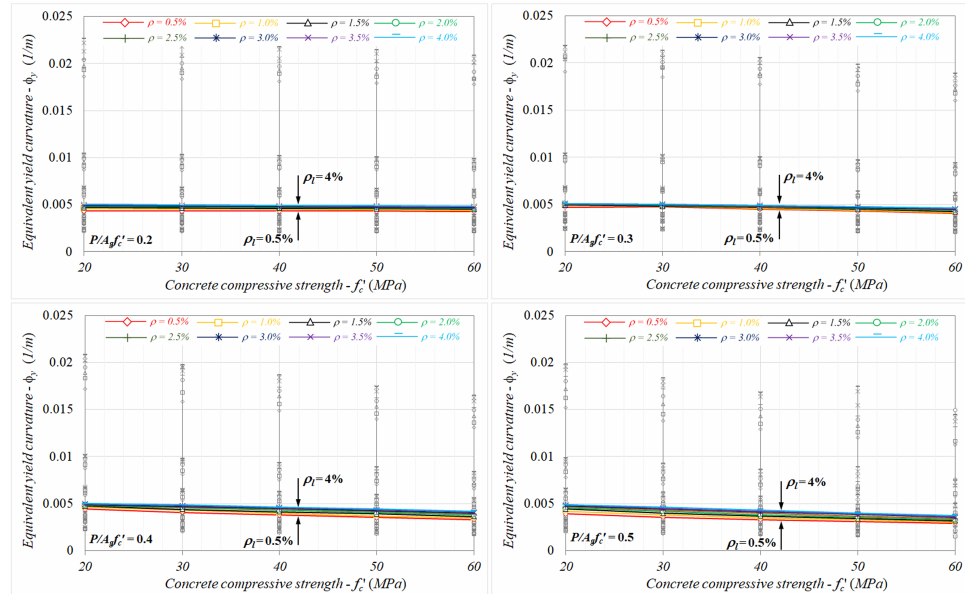
Figure 8. The variations of equivalent yield curvatures with the concrete compressive strength in terms of di ff erent ( a ) axial load levels, ( b ) column dimensions, and ( c ) reinforcement ratios.